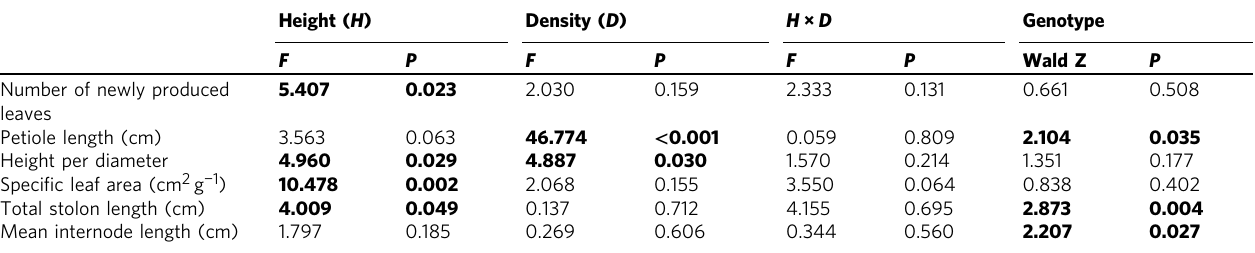
Table 1 Generalised linear mixed model results for the effect of fi lter height and density on P. reptans responses